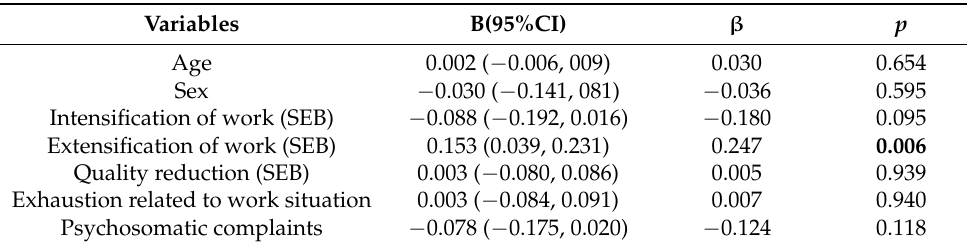
regression analyses #.